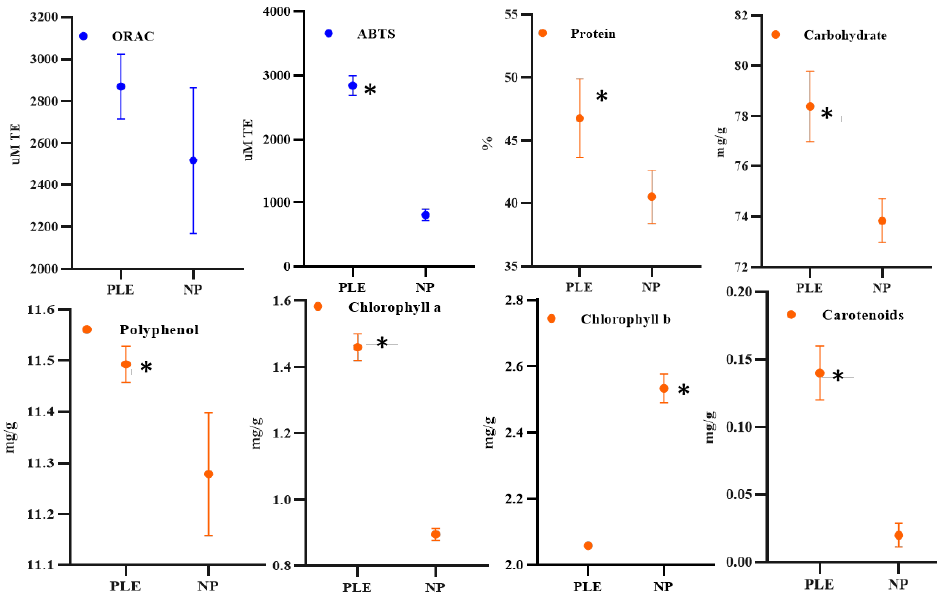
Figure 5. Biomass and antioxidant capacity of PLE and non-pressurized (NP) extracts. Note: * indicate significant differences ( p < 0.05).